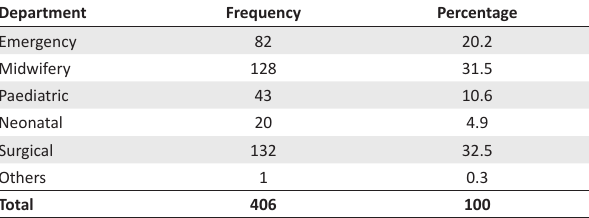
TABLE 1: Department frequency distributions.